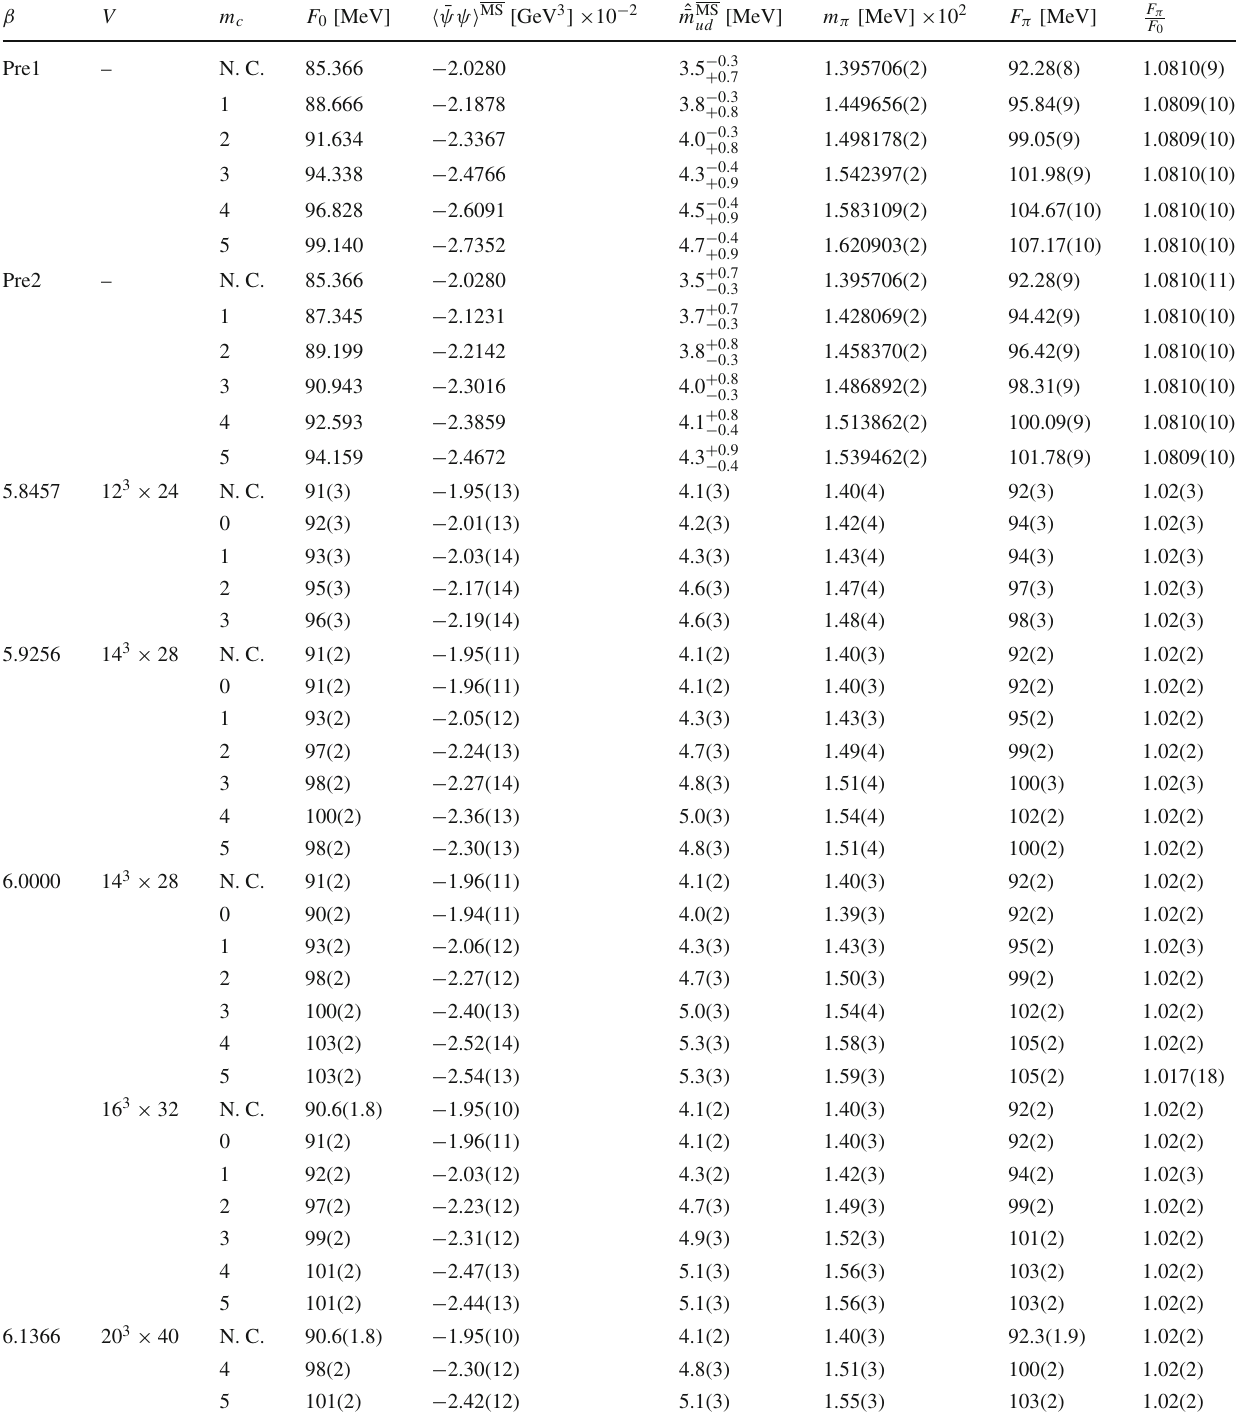
Table 33 The outcomes of the decay constant F 0 , renormalized chi- ral condensate (cid:5) ¯ ψψ (cid:6) MS and average mass of light quarks ˆ¯ m MS MS-scheme at 2 [GeV], pion mass m π and decay constant F π , and